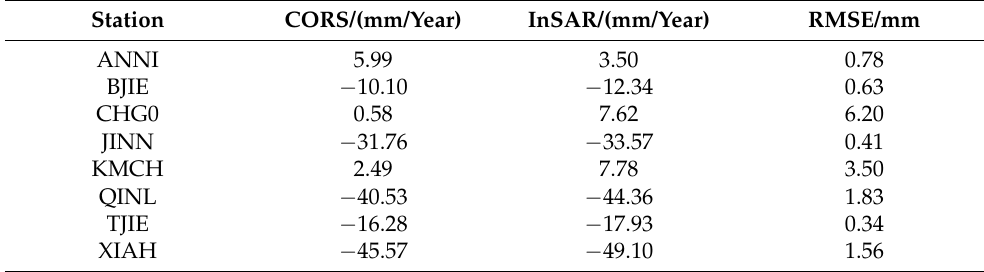
Figure 10. Vertical velocity field after interpolation. Table 1. Comparison of annual average deformation rates between InSAR and CORS